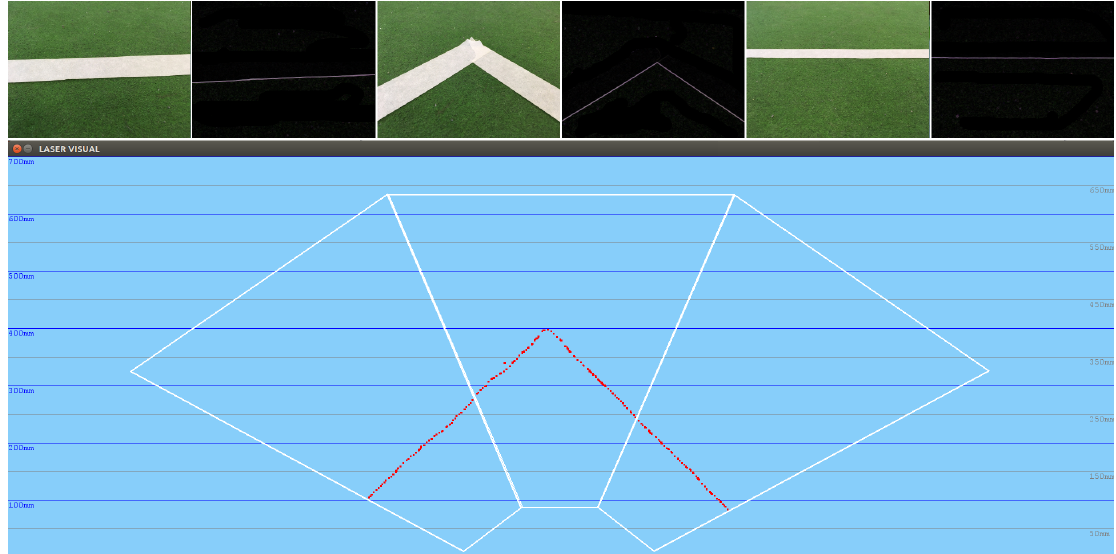
Figure 7. 3D edges corresponding to the edges of the three 2D snapshots images.